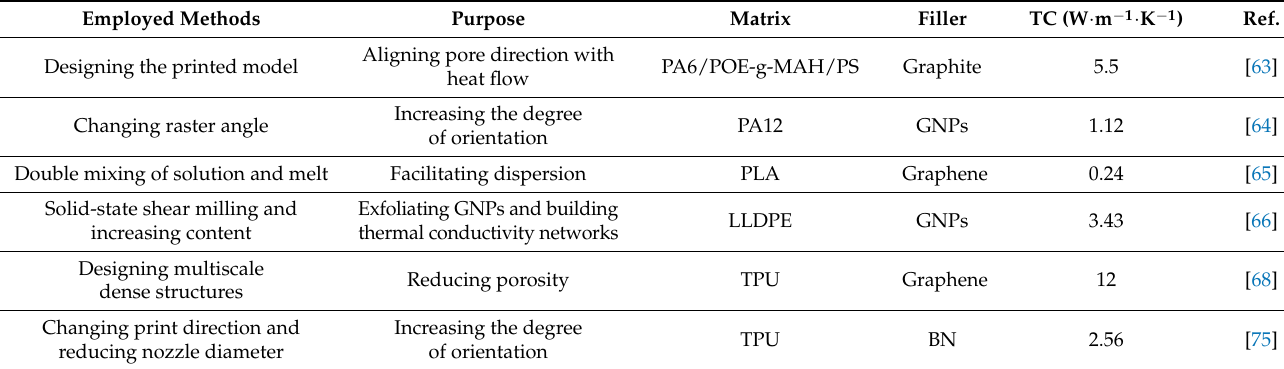
Table 3. Summary of methods to improve the thermal conductivity of FFF 3D